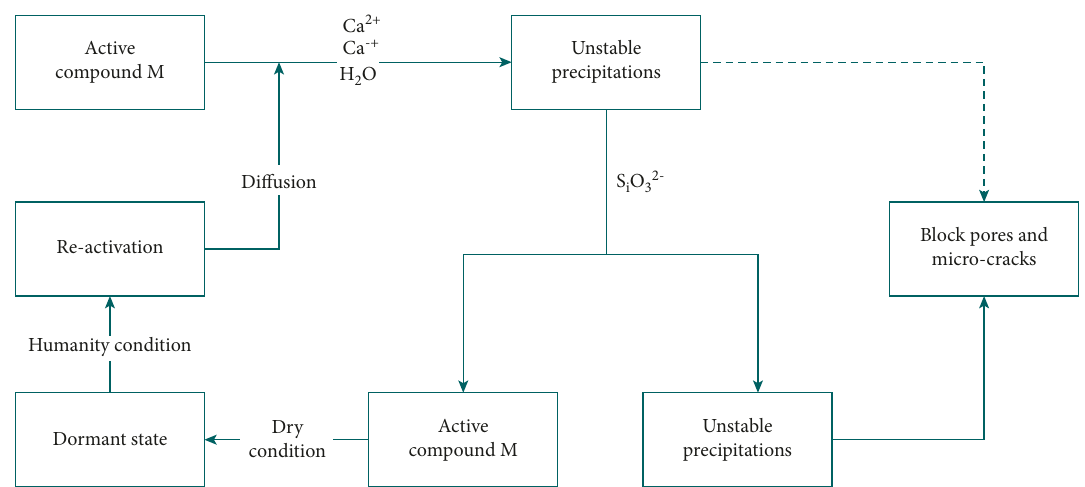
Figure 10: Mechanism of circulation crystalline reaction (between humanity and dry